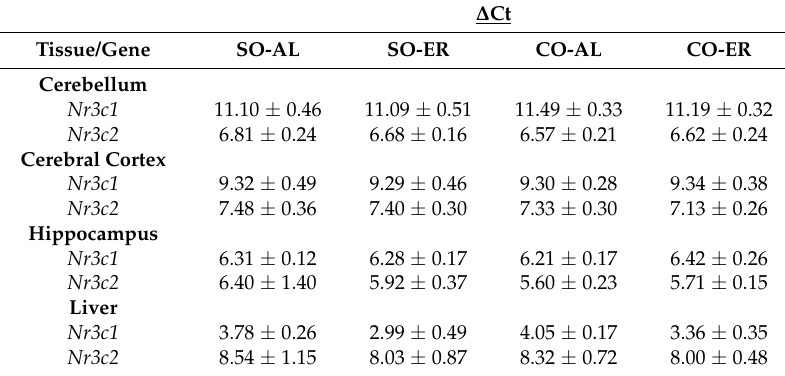
Table A3. ∆ Ct values for glucocorticoid and mineralocorticoid